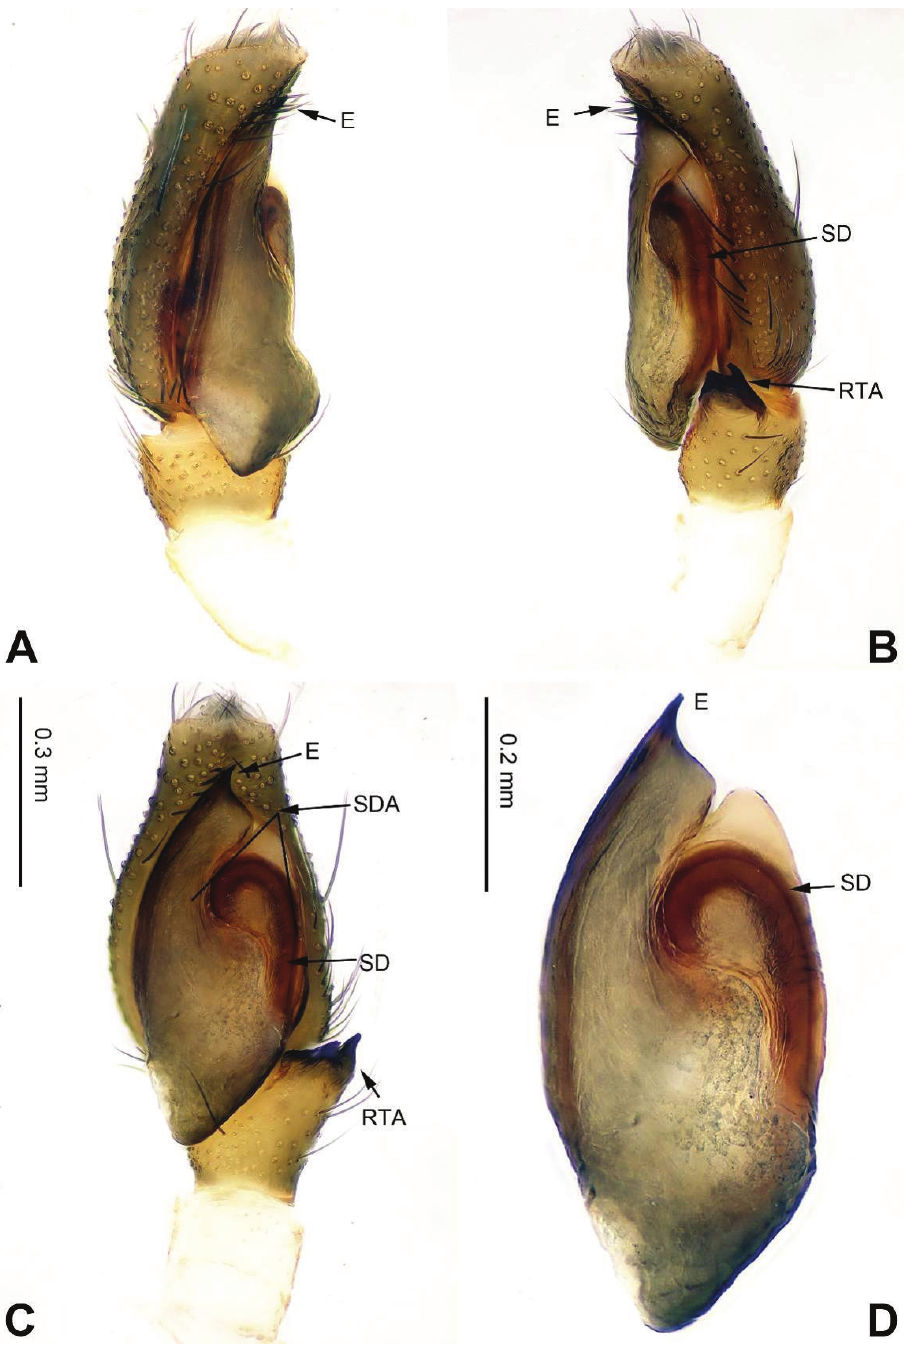
Figure 36. Palp of Phintella suavisoides , male from Xishuangbanna. A prolateral B retrolateral C ventral D bulb, ventral. Scale bar equal for A–C